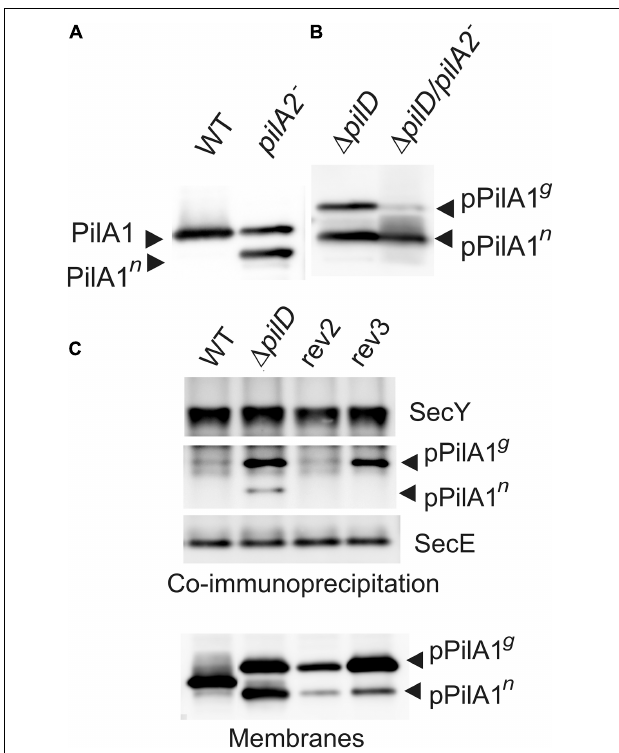
FIGURE 7 | The role of pilA2-sll1696 operon in the PilA1 biogenesis and the co-immunoprecipitation of the SecY translocase with prepilin. (A) Immunodetection of PilA1 in membrane proteins isolated from WT and pilA2 − cells grown under Glc − conditions. Membrane proteins were separated by SDS-PAGE and blotted; PilA1 n indicates a putative non-glycosylated form of PilA1. (B) Immunodetection of pPilA1 in separated membrane proteins from (cid:49) pilD and (cid:49) pilD / pilA2 − cells. Both strains were grown in Glc + conditions. (C) The anti-SecY antibody was incubated with membrane proteins isolated from the WT, (cid:49) pilD mutant and rev2 and rev3 strains grown in Glc + conditions and then immobilized on Protein A—Sepharose (Sigma, Germany), eluted in SDS buffer, and separated by SDS-PAGE. The gel was blotted and probed with anti-SecY and anti-PilA1 antibodies; the anti-SecE antibody was re-probed as a control. The level of PilA1 forms is also shown for the identical membrane samples to those used for the